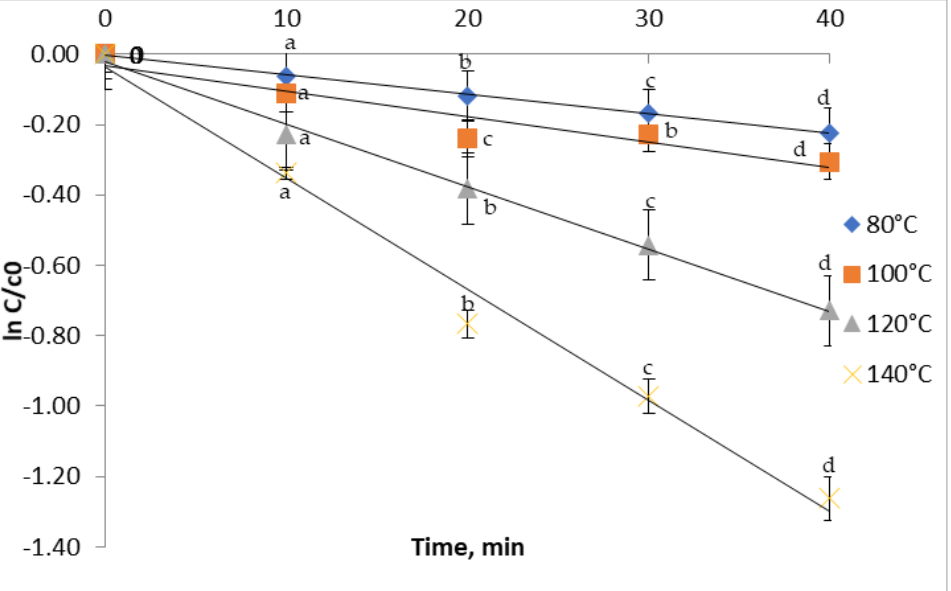
Figure 2. Isothermal degradation of TAC in the red grape skin extract treated at different temperatures.